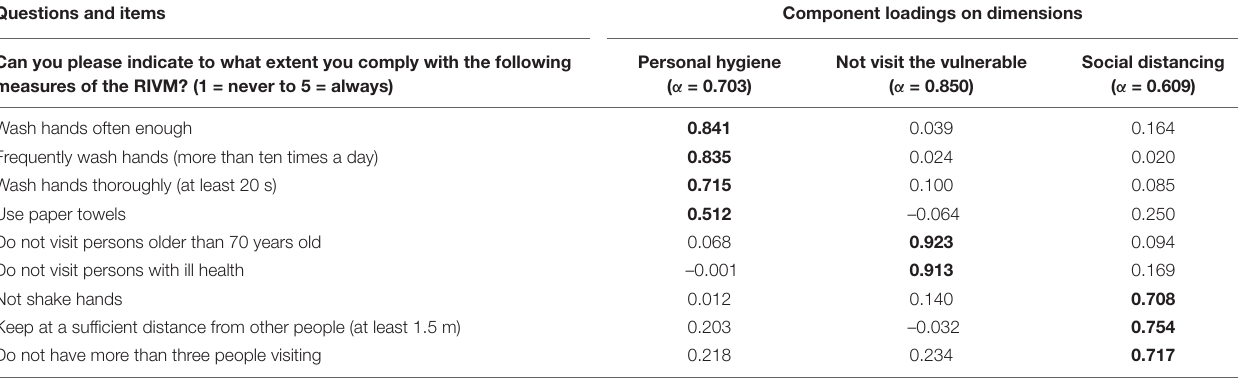
TABLE 4 | Rotated component matrix of complying to Corona measures items (Study 2). Questions and items Component loadings on